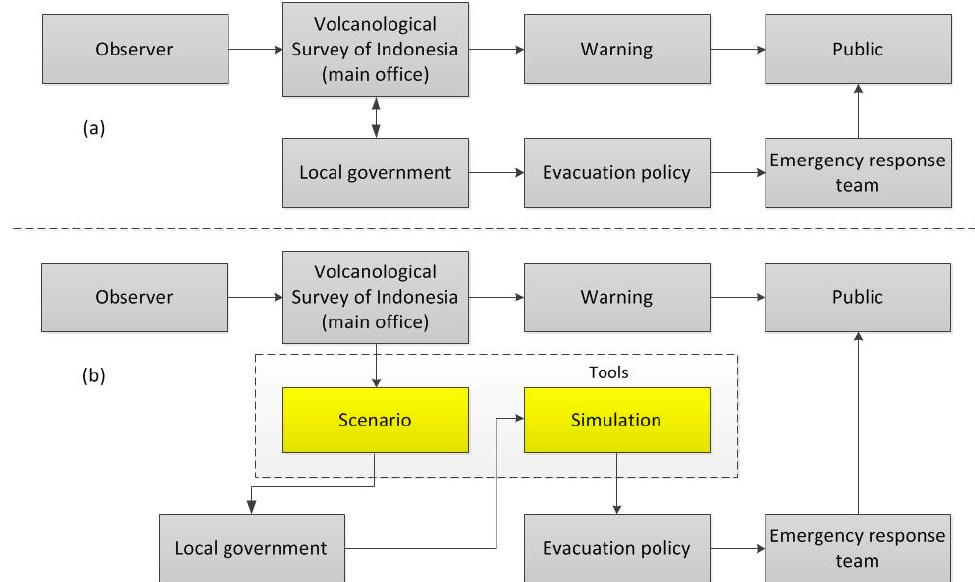
Figure 14. Attachment of the model to evacuation decision process (modified from [38]). (a)